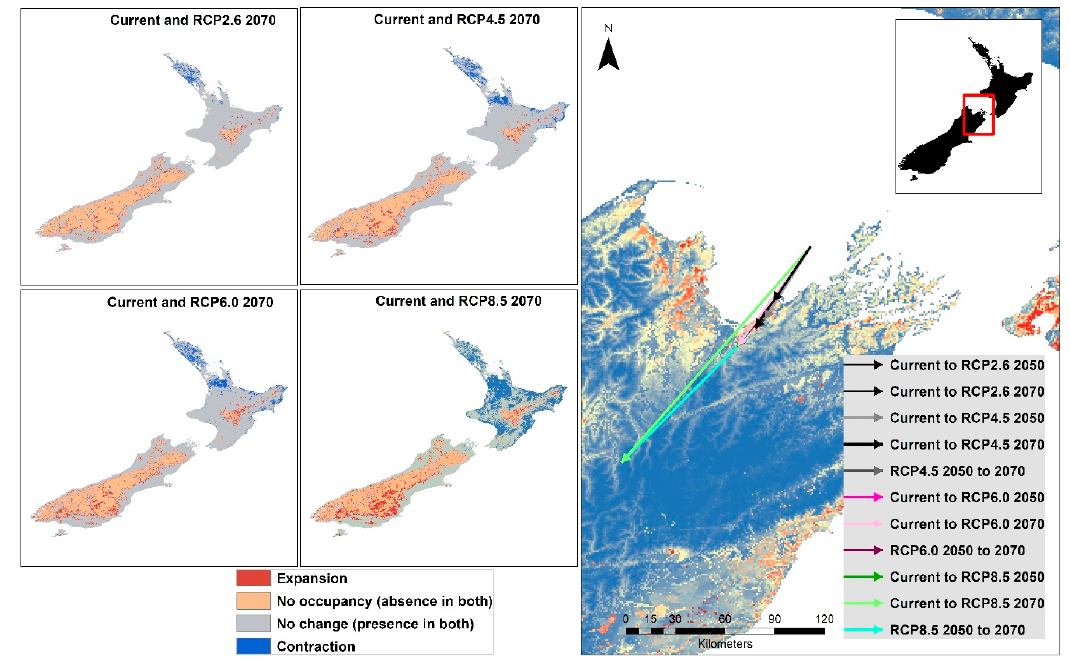
Figure 8. Changes in range of the Mexican daisy from current to 2070 under different RCP trajectories and shift of centroids of the thresholded rasters.